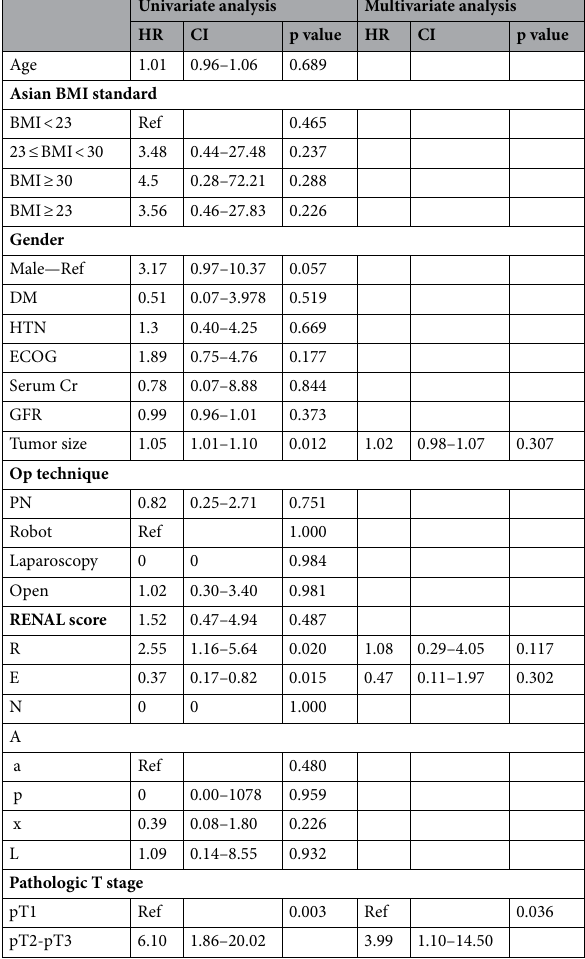
The significant predictor of recurrence was the pathologic T stage (hazard ratio [HR] = 3.99, 95% confidence [CI]: 1.10–14.50, p = 0.036) (Table 2). The significant predictor of death was the R portion of the RENAL (HR